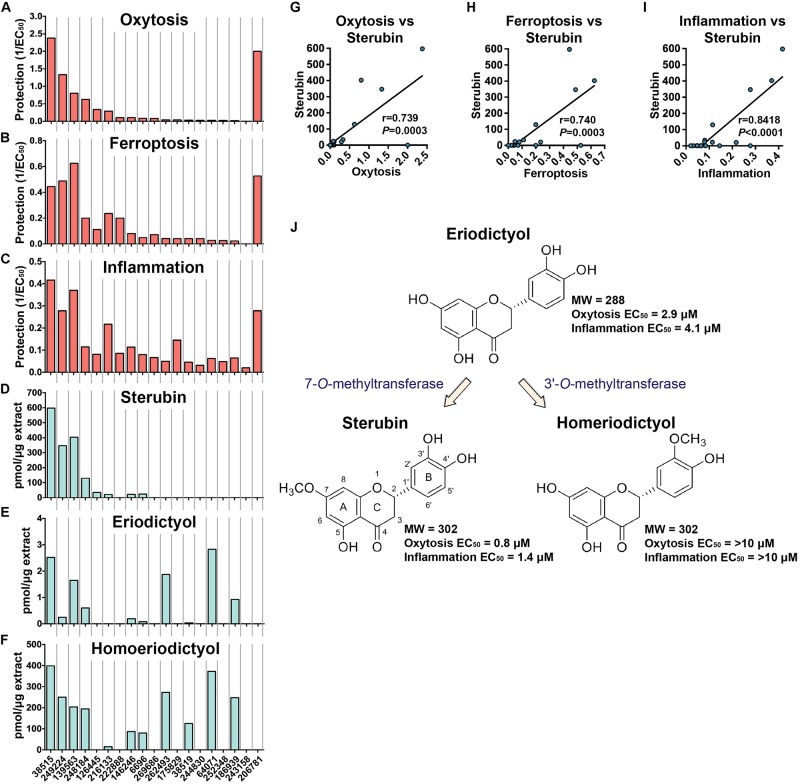
Biological protection and chemical information. Protection against oxytosis (A), ferroptosis (B), and inflammation (C) by the Eriodictyon extracts are indicated as inverted EC50 (1/EC50). Levels of sterubin (D), eriodictyol (E), and homoeriodictyol (F) are calculated as picomol per microgram of dried DCM extract (pmol/μg). Species are ordered from left to right according to Table 2. Correlation graphs between sterubin levels and protection against oxytosis (G), ferroptosis (H), and inflammation (I). (J) Chemical structures and proposed biosynthetic pathway of sterubin, eriodictyol, and homoeriodictyol are shown, with respective MW and EC50 protection against oxytosis and inflammation.